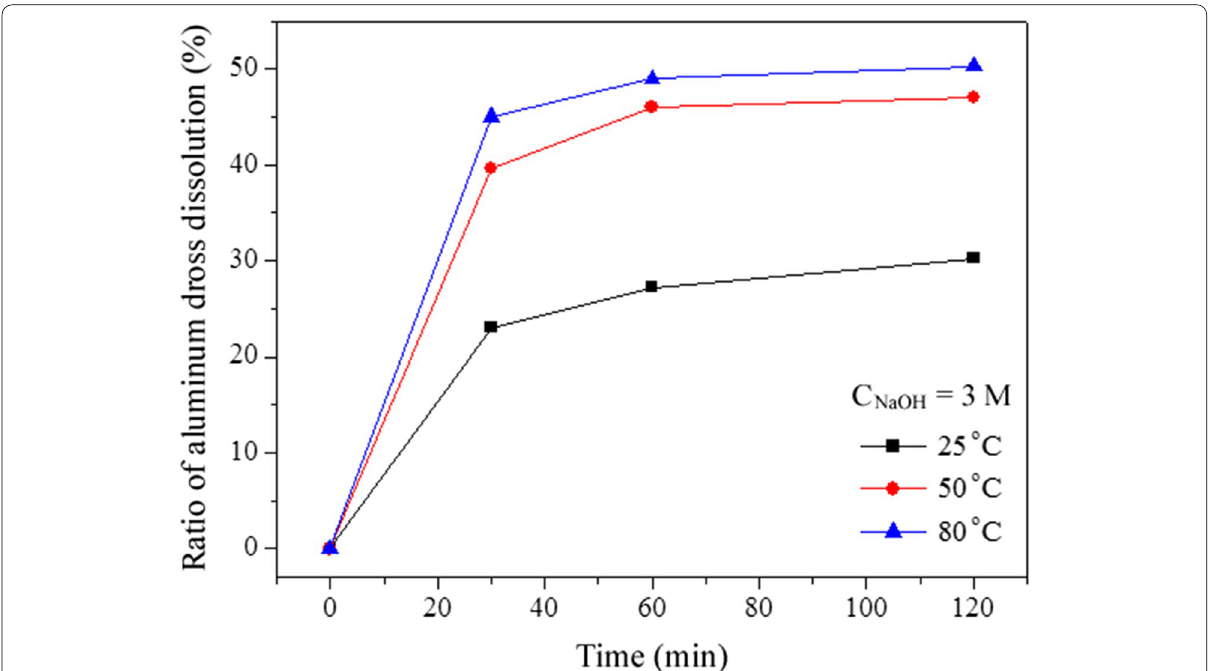
Fig. 4 Influence of temperature and time on aluminum dross dissolution